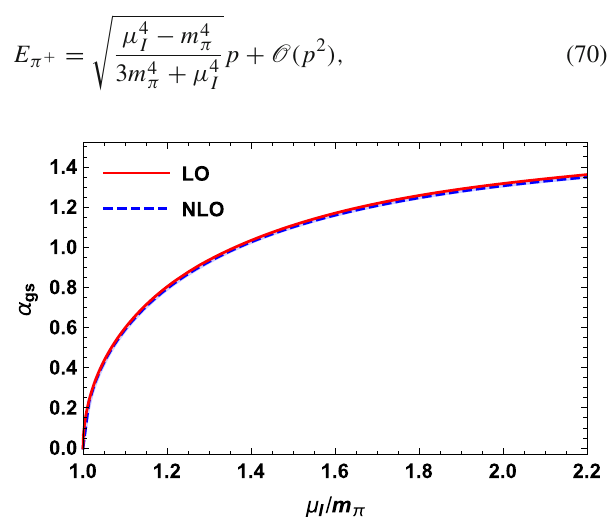
Fig. 1 α that minimizes the effective potential as a function of isospin chemical potential μ I . The red curve is the LO results, while the blue curve is the NLO